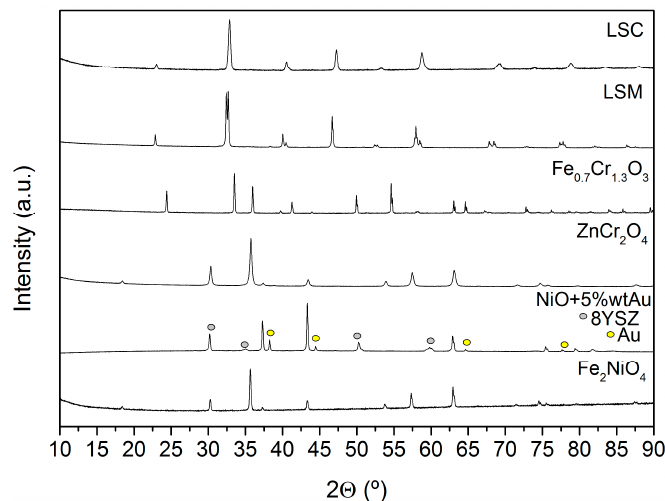
Figure 2. X-ray diffraction patterns of the materials studied at room temperature once they are synthesized.